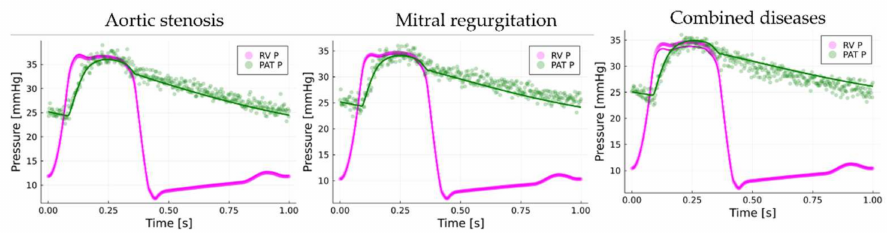
Figure 6. Pulmonary arterial and right ventricular pressure waveforms predicted by the model, along with predicted important PAP values using increased pulmonary arterial resistance. Solid lines—predicted values; markers—actual waveforms + noise.